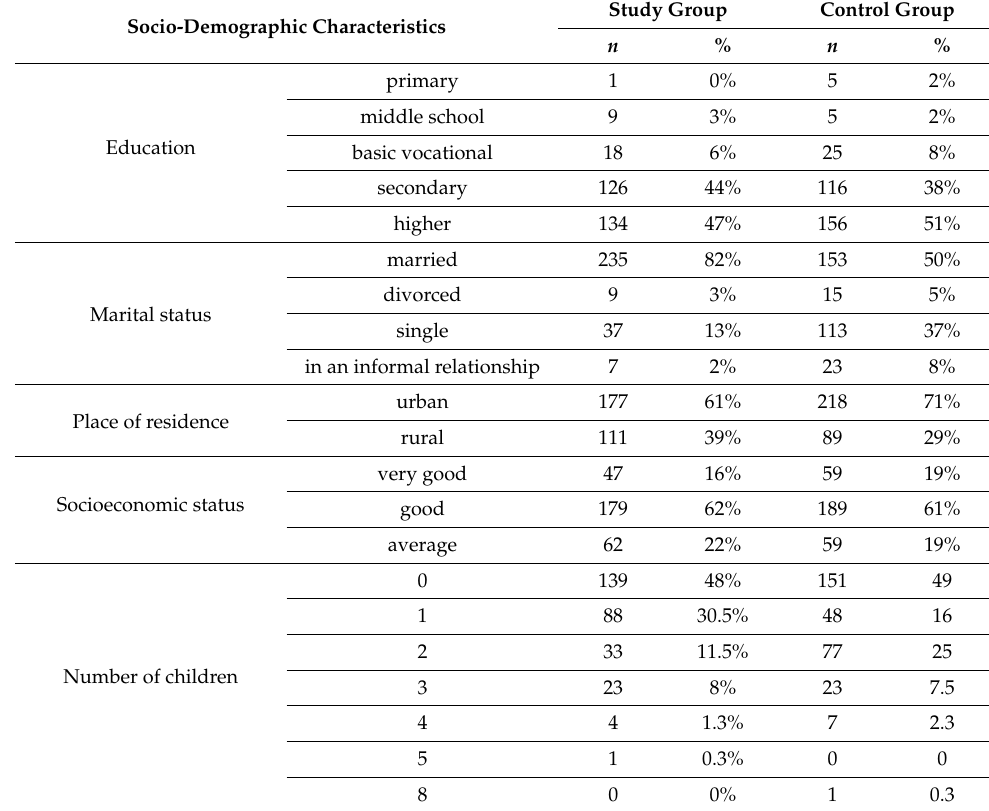
Table 1. Socio-demographic characteristics of